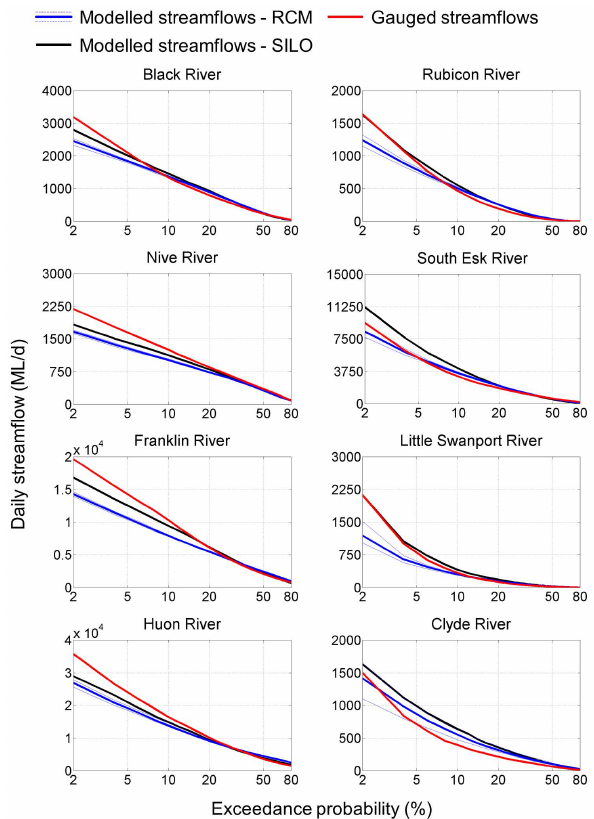
Fig. 8. Comparison of mean monthly modelled and gauged stream- flows for 1961–2007. Blue line shows streamflows modelled with SIMHYD forced by the RCM, faint blue lines give range of the six RCM simulations, black line shows SIMHYD forced by SILO and red line shows gauged streamflows.